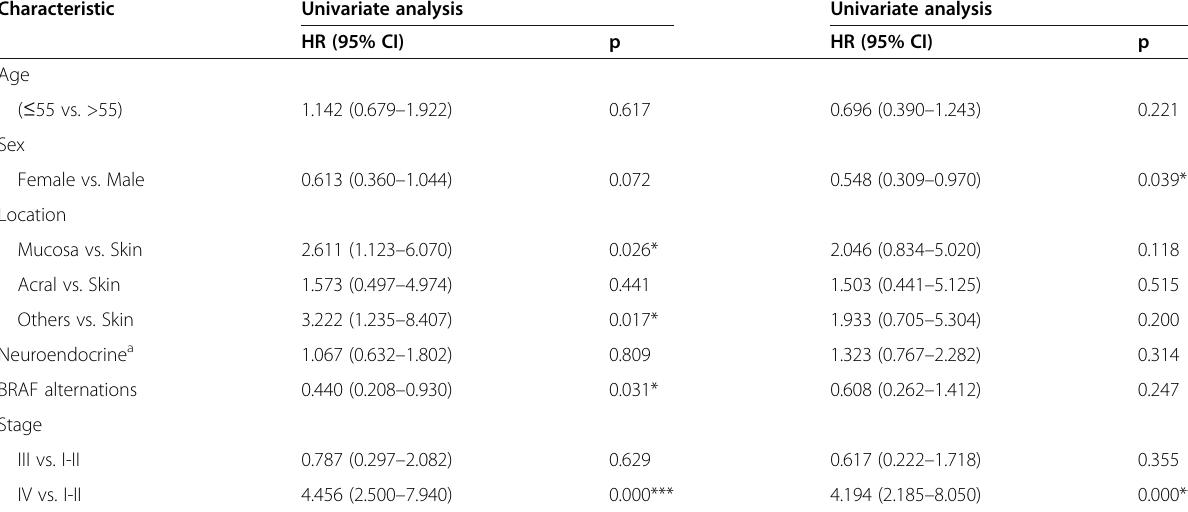
Table 4 Univariate and multivariable Cox proportional hazards model for OS